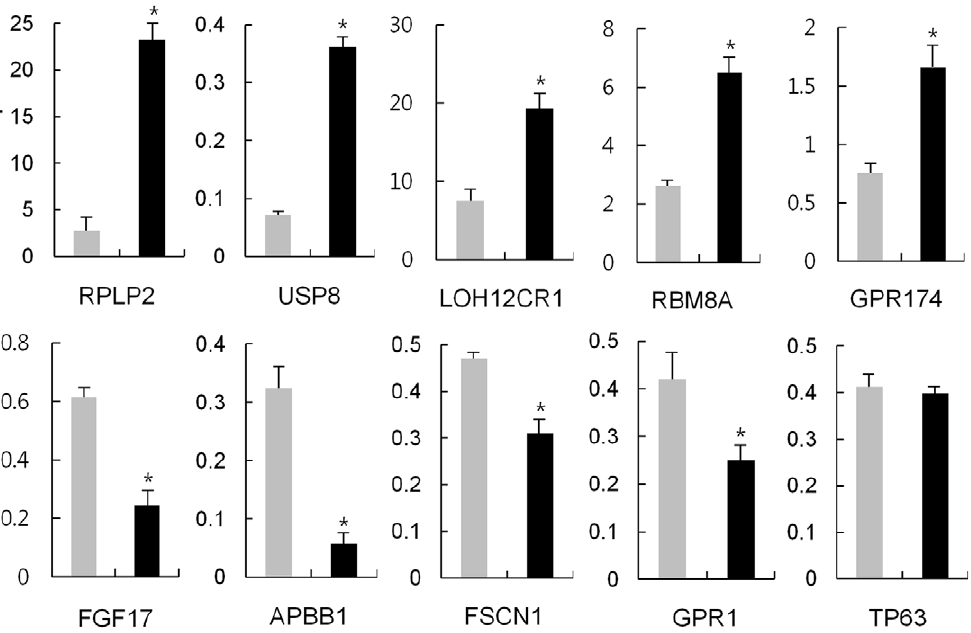
Figure 6. RT-PCR analysis of selected genes induced by sLF. Real-time RT-PCR analysis of ten selected genes displaying altered expression in response to sLF in HEK293 cells. Gray and black bars denote the expression of the indicated genes for non-treated and treated with tetracycline in the sLF cells, respectively. Each sample was analyzed in duplicate, and the average relative expression level of 15 clones is presented. *Significant (P , 0.05; Student’s t